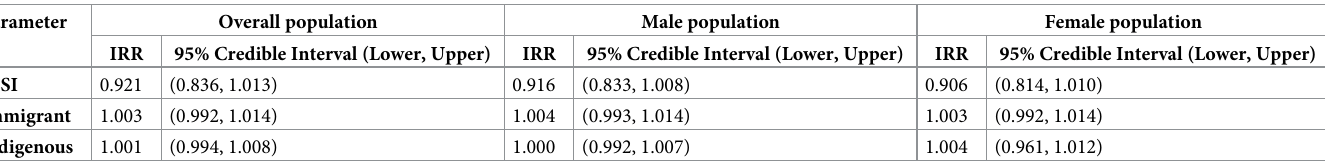
Table 2. Incidence Risk Ratio (IRR) and 95% credible interval for overall, male and female GC dataset using spatial Poisson regression model. Parameter Overall